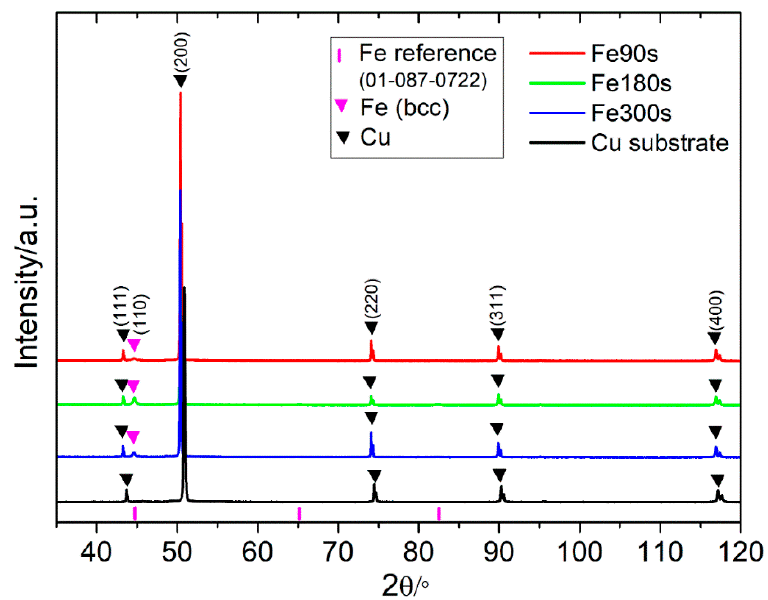
Figure 1. Diffractogram of the different Fe samples obtained by DHBT. The black curve shows the diffractogram of the copper substrate alone.